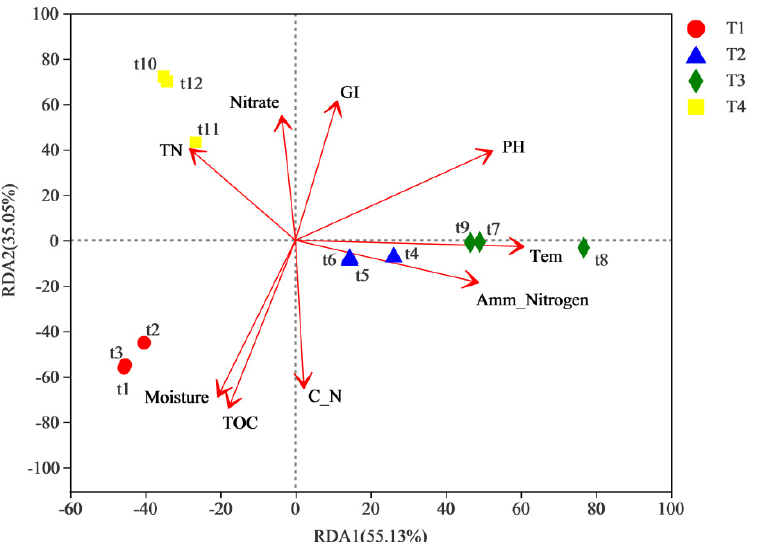
Figure 5. Multivariate redundancy analysis of bacterial and chemical properties (arrows) at different phases of composting.